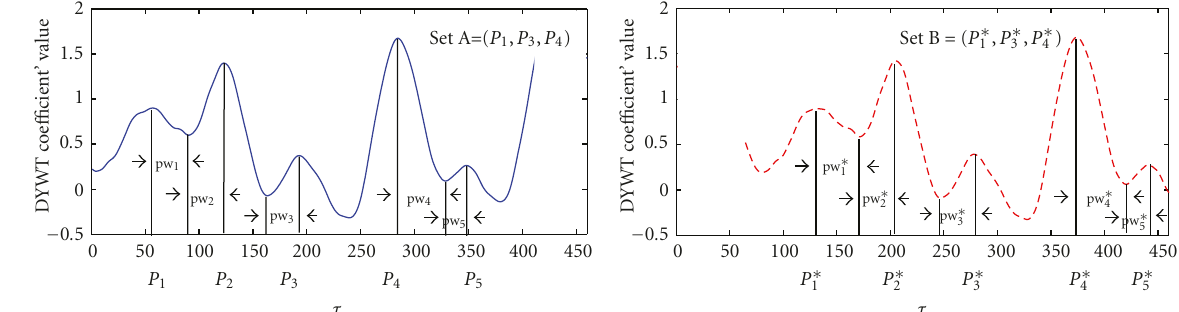
Figure 4: The widest peaks used for embedding and extracting watermark bits.